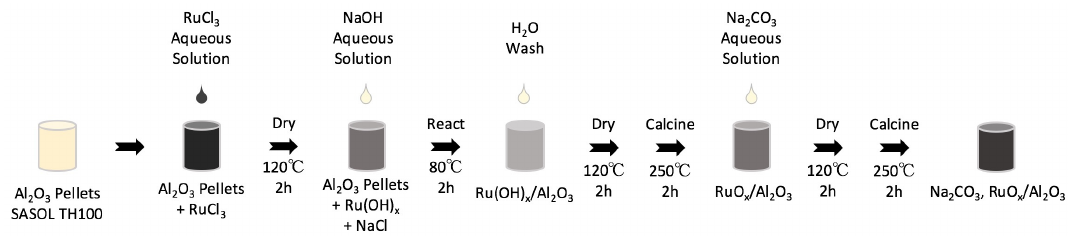
Figure 8. Ru-Na 2 CO 3 DFM pellet preparation process flow using the precipitation method. A slight excess of NaOH was used with a ratio of Ru:OH = 1:4.5 to precipitate Ru(OH) x . A water wash and filtration (40 times of water immersion and separation) was used to remove any NaCl. Drying and calcination steps were conducted in air.